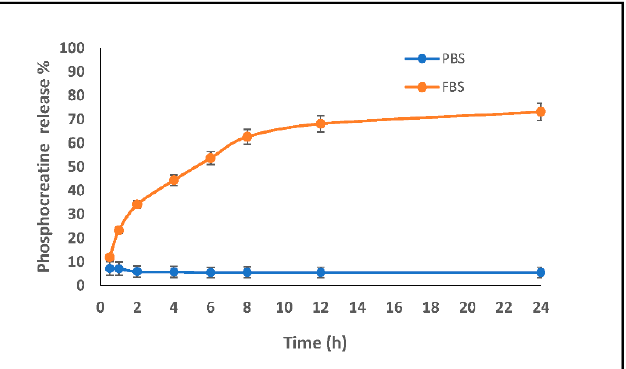
Figure 4. In vitro release kinetics of PCr from PLGA-T3 NPs/PCr in FBS and PBS using HPLC. The